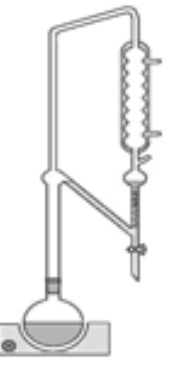
Figure 4. Clevenger